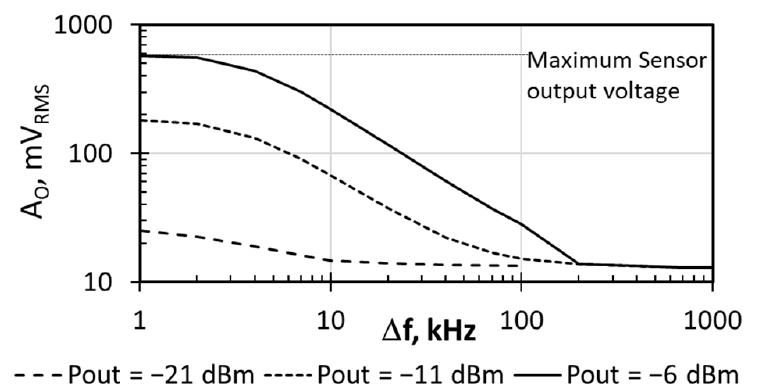
Figure 12. Sensor output voltage amplitude as a function of ∆ f for three different output power levels. DMM measurements .